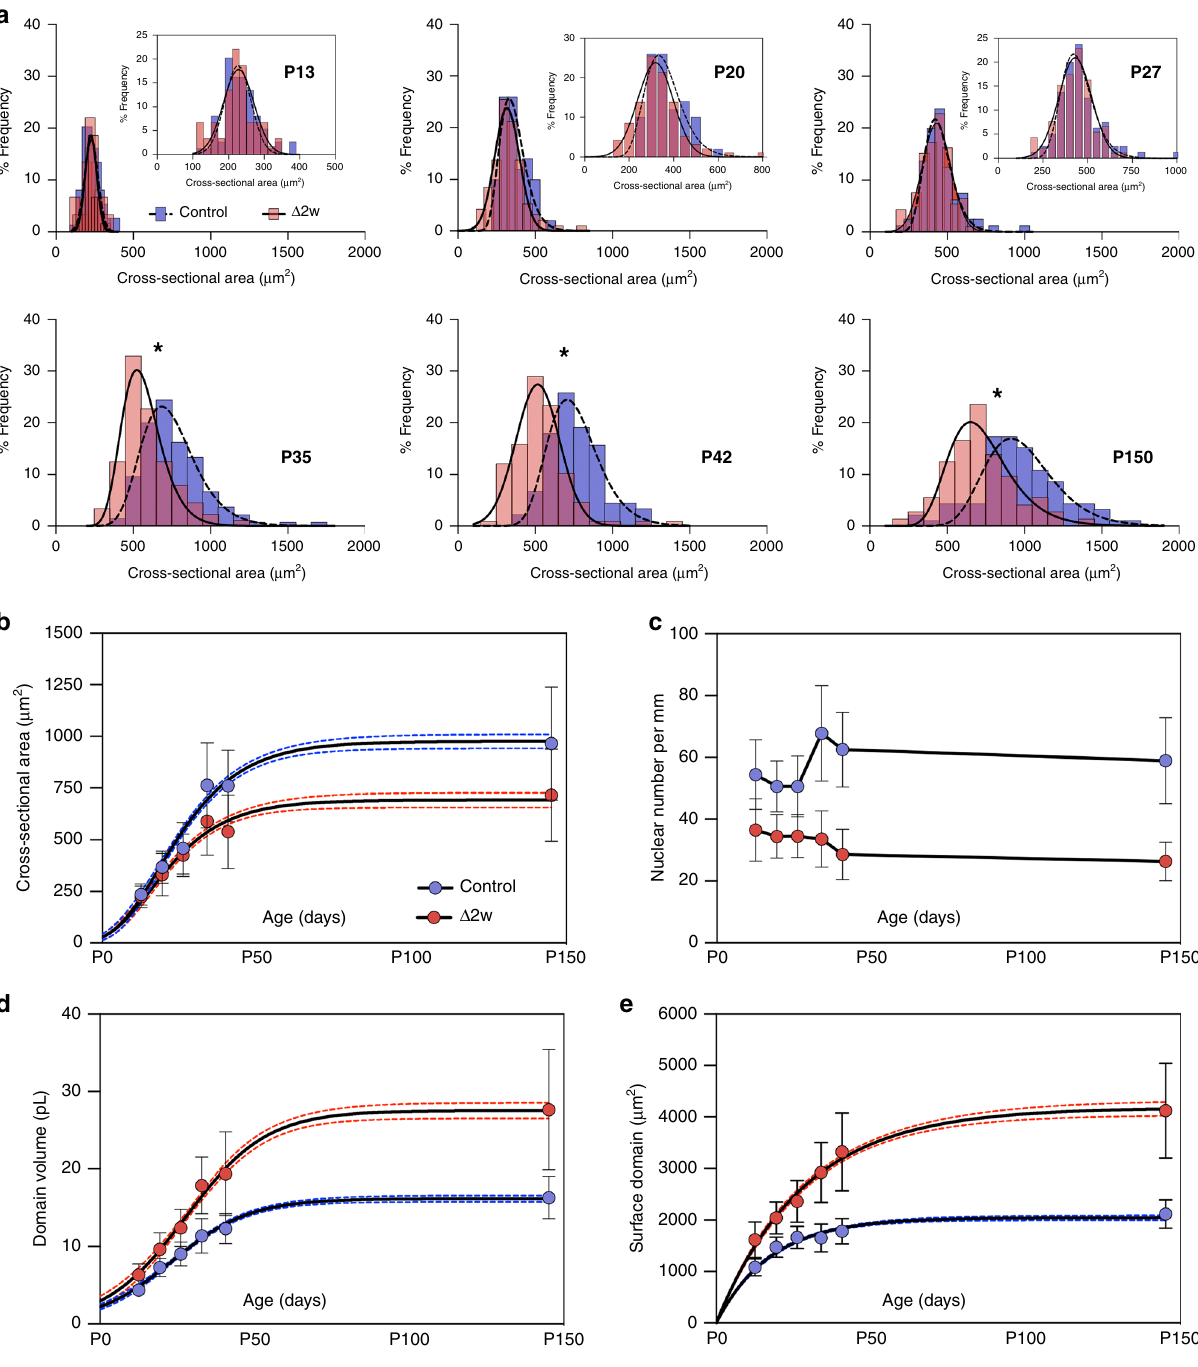
Fig. 4 Inhibiting myonuclear accretion genetically causes smaller muscle fi bers and larger myonuclear domains during development. a Frequency distribution of cross-sectional area from P13 to P150 between normal EDL cells (blue, dashed Gaussian line) and Δ 2 w cells (red, solid Gaussian line). Inset in P13 – P27 shows the zoomed distribution. Asterisks (*) indicate nested two-sided t -test results: P35 ( p = 0.0075, t = 3.56, and df = 8), P42 ( p = 0.0067, t = 4.45, and df = 5) and P150 ( p < 0.0001, t = 6.29, and df = 162), while for the remaining age-matched comparisons: P13 ( p = 0.4838, t = 0.7708, and df = 4), P20 ( p = 0.2830, t = 1.239, and df = 4) and P27 ( p = 0.8157, t = 0.2488, and df = 4). b – e Size-related parameters plotted against age for cross- sectional area ( b ), nuclear number ( c ), nuclear domains ( d ), and fi ber surface domains ( e ). Solid lines in b and d were fi tted to data using a logistic growth model, while e was fi tt e d by an exponential plateau function. Dashed lines represent 95 % CI and each data point represents the mean value with the standard deviation as error bars. df = degrees of freedom. All data in a – e were calculated from the following number of control cells: P13 = 74 cells, P20 = 50 cells, P27 = 80 cells, P35 = 135 cells, P42 = 89 cells, and P150 = 92 cells. The number of myomaker Δ 2 w cells were; P13 = 59 cells, P20 = 94 cells, P27 = 92 cells, P35 = 88 cells, P42 = 107 cells, and P150 = 72 cells. Source data are provided as a Source Data fi